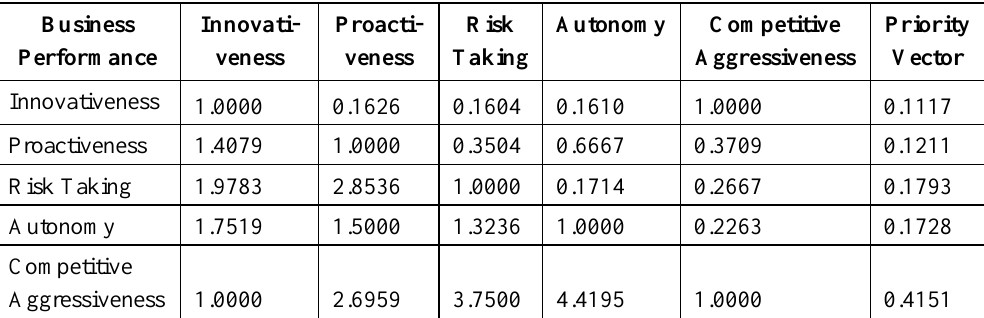
Table 1. Reduced Matrix for Determinant of Business